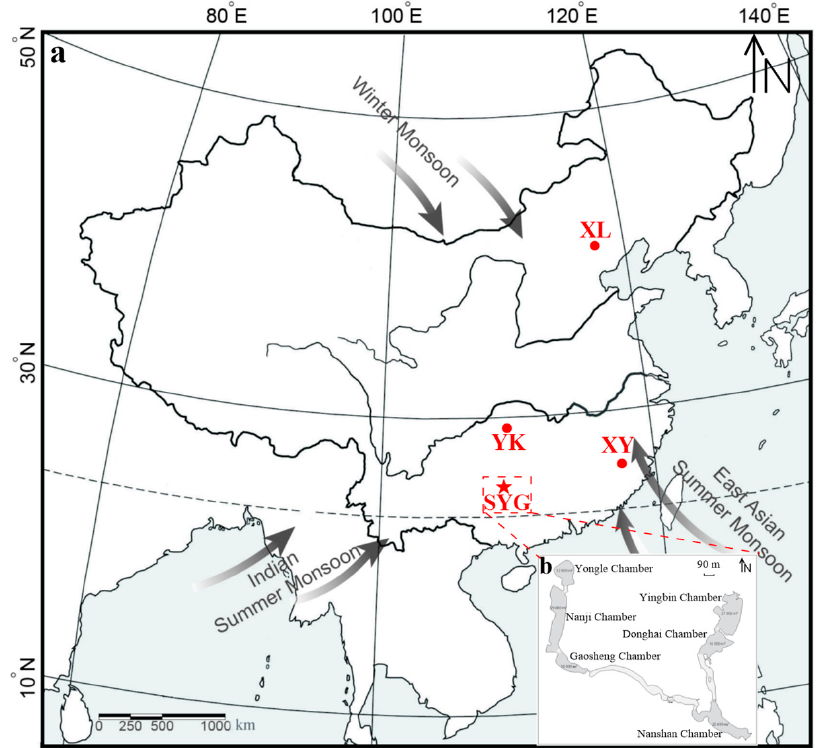
Figure 1. Regional climatology, cave sites ( a ) and the plan of Shouyuangong Cave ( b ). Averaged JJA water vapor flux between 1949 and 2016 [22]. Red dots indicate locations of Xinglong Cave (XL, 40 ◦ 29 (cid:48) N, 117 ◦ 29 (cid:48) E, [23]), Yangkou Cave (YK, 29 ◦ 01 (cid:48) N, 107 ◦ 11 (cid:48) E, [24]) and Xianyun cave (XY, 25 ◦ 33 (cid:48) N, 117 ◦ 00 (cid:48) E, [25]). Red star indicates location of Shouyuangong Cave (SYG, 24 ◦ 25 (cid:48) N, 107 ◦ 01 (cid:48) E, this